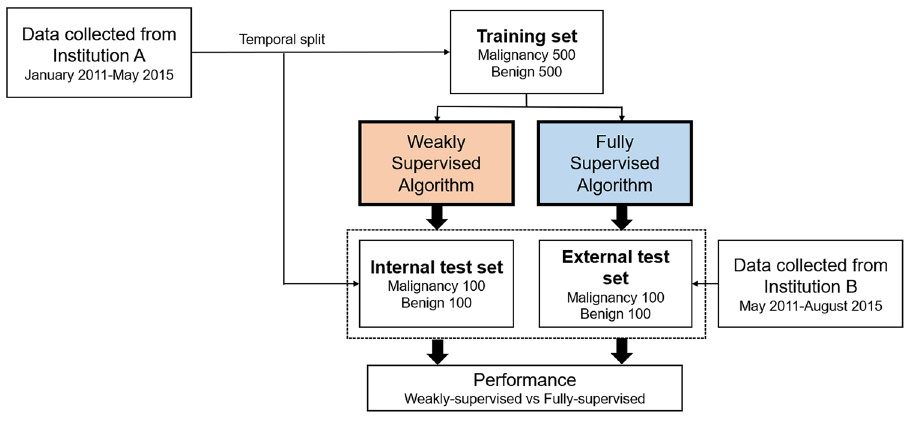
Figure 1. Overview of the data